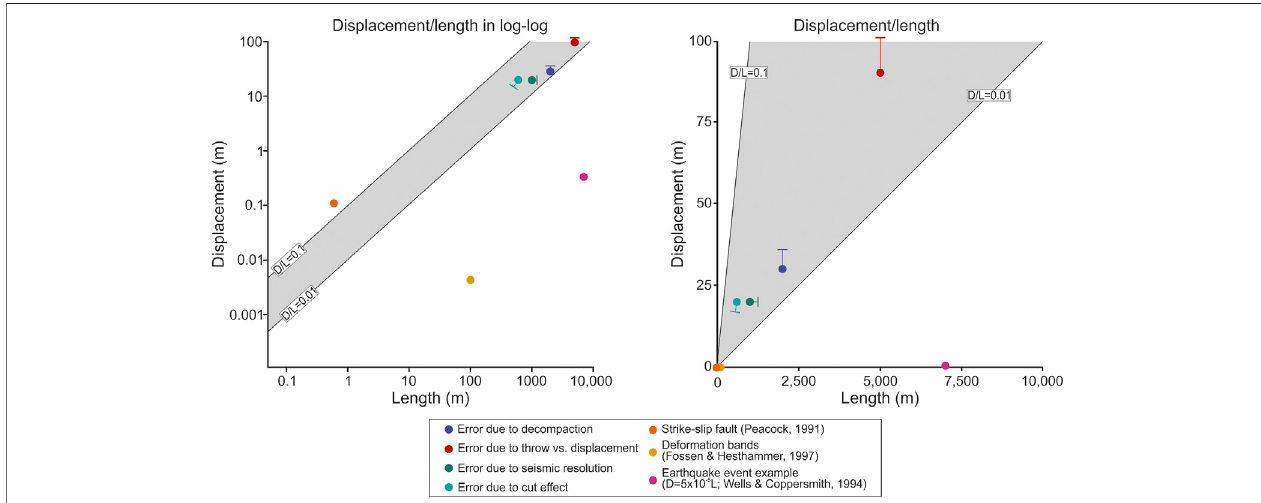
FIGURE1| SchematicshowinghowerrorsinmeasurementanddatafromstructuresotherthannormalfaultsthatcanaffectD/Lscalinginlog-logandlinearspace. Dots signify observed values and one-sided error bars delineate where the observed value should be.